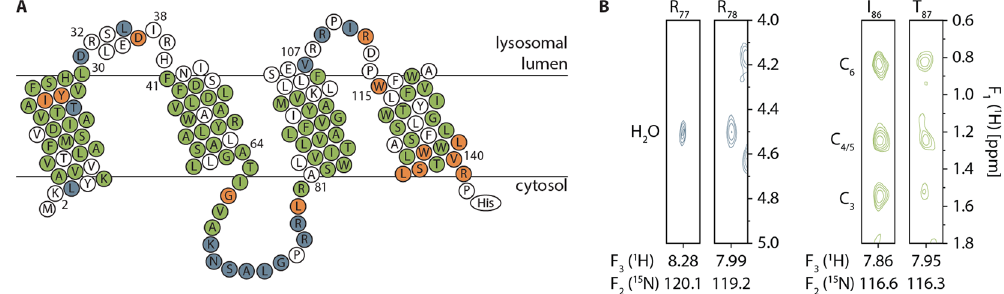
Figure 4. Secondary structure of TMD0. ( A ) Backbone chemical shifts derived from a series of HN-detected 2D triple resonance NMR spectra of cf-TMD0-His were used to generate a secondary structure model by TALOS-N. The numbers depict the first and last residue of each helix. Topology of cf-TMD0-His was derived from NOEs between 2 H partially and 15 N uniformly labeled cf-TMD0-His and protons of the hexanoyl side chains of c6-DHPC (green residues) and from cross-peaks with H 2 O (blue residues). Residues at the water micelle interface are involved in both restraints (orange residues). The N- and C-termini of cf-TMD0-His are oriented in the cytosol to fit within the overall topology with coreTAPL. ( B ) Exemplarily, exchange cross-peaks with H 2 O (left) and NOEs with c6-DHPC hexanoyl sidechains (right) in a 3D NOESY-BEST-[ 15 N, 1 H]-TROSY experiment (950 MHz, mixing time 300 ms) at 323 K of 2 H partially and 15 N uniformly labeled cf-TMD0-His (600 µ M) are shown for an unstructured loop region (R 77 -R 78 ) and an α -helical segment (I 86 -T 87 ). Spectral sections are taken at F 2 ( 15 N) chemical shifts and centered (0.1 ppm) at the 1 H chemical shifts (F 3 ). 1 H (F 1 ) chemical shifts for H 2 O and C 3 , C 4/5 and C 6 of c6-DHPC hexanoyl side chain are